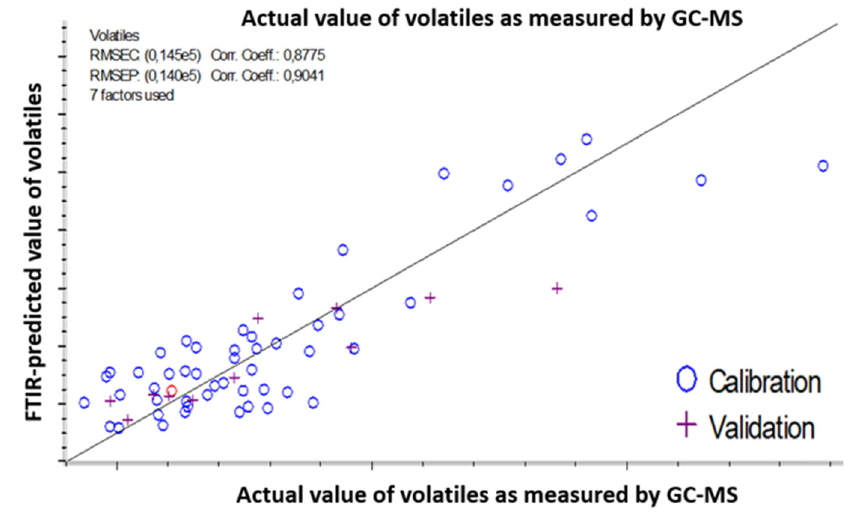
Figure 5. Partial least squares regression (PLSR) analysis prediction model of the oxidation level of liquid milk infant formula: correlation between the actual value of volatiles as measured by headspace solid-phase microextraction gas chromatography coupled to mass spectrometry (HS-SPME-GC-MS) ( x -axis) and the volatiles values predicted from the spectral changes happening over the whole spectral range of ATR-FTIR spectra ( y